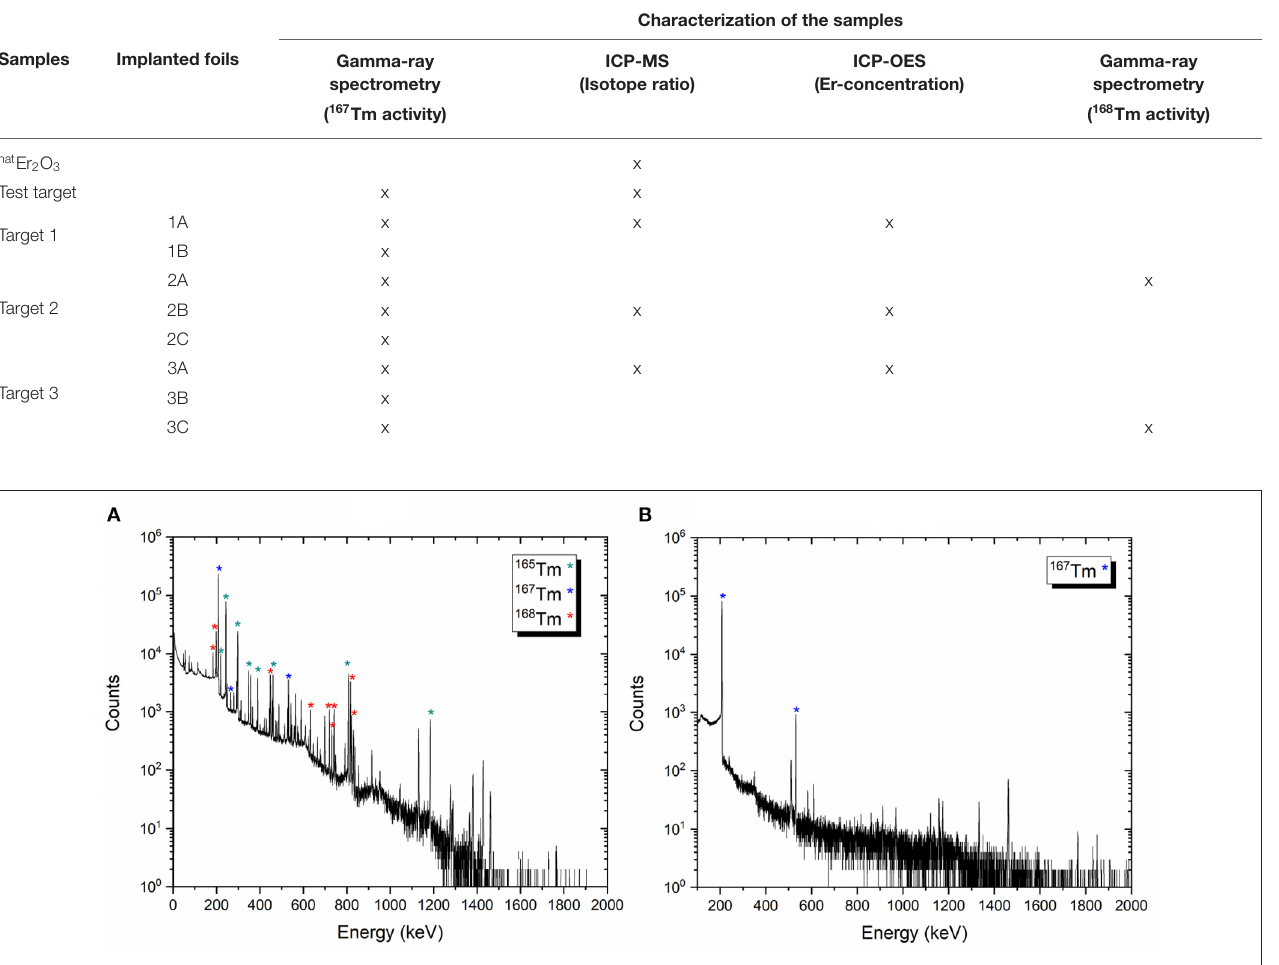
FIGURE 9 | Examples of the gamma-ray spectra of the target material before mass separation process on target 2 (A) and 167 Tm implanted foil 2A (B)